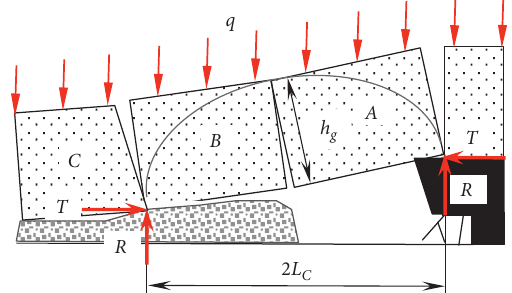
Figure 3: Schematic diagram of the overburden broken structure in